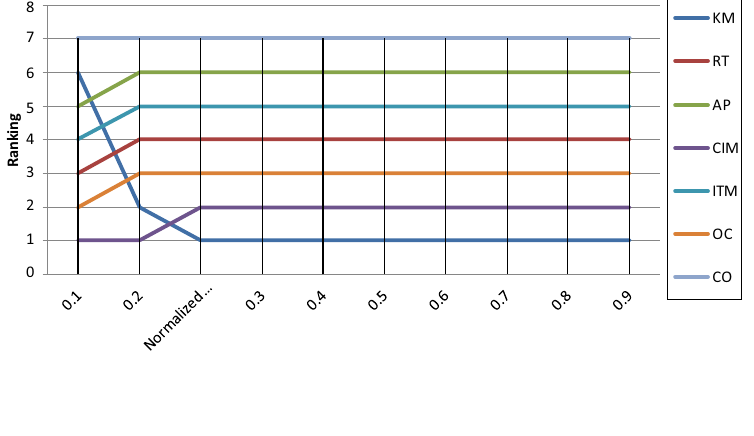
Figure 3. Ranking of enablers obtained in sensitivity analysis run